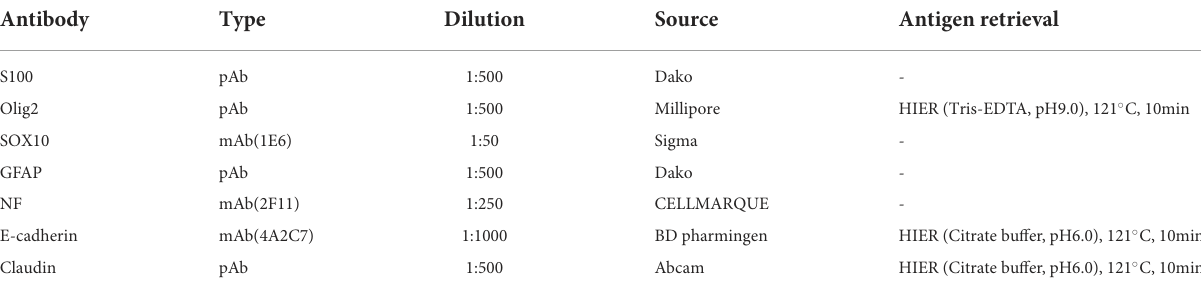
TABLE 1 Primary antibodies and protocols for immunohistochemistry.